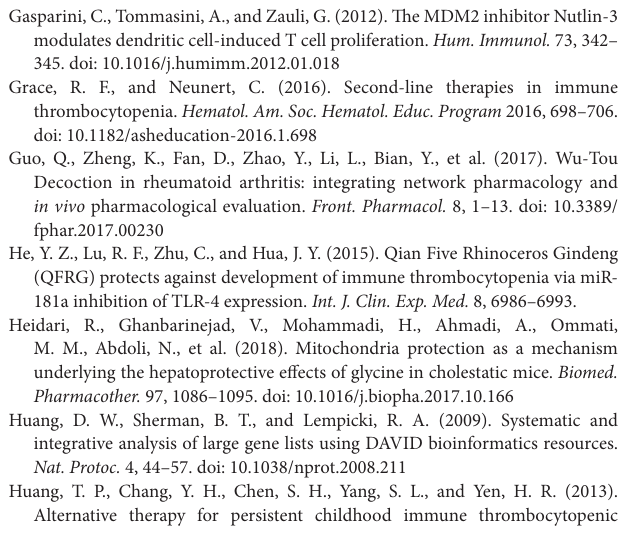
TaBlE S1 | The data of GO enrichment analysis including biological process, cellular component, and molecular function. TaBlE S2 | The data of KEGG pathway enrichment